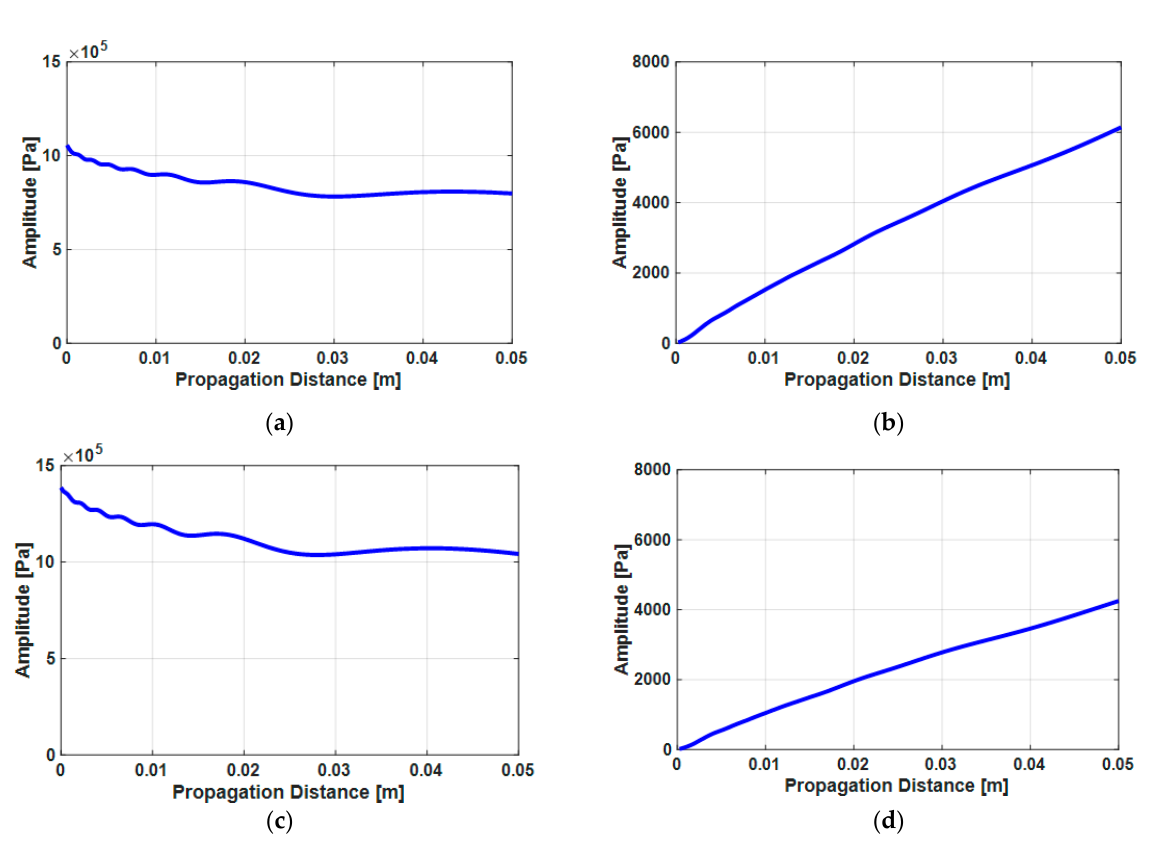
Figure 4. The received pressure amplitude on the receiver as a function of the distance to the transmitter, obtained from the average of the sound pressure in Figure 3: ( a ) the received fundamental amplitude and ( b ) the received second harmonic amplitude in the fused silica; ( c ) the received fundamental amplitude and ( d ) the received second harmonic amplitude in the Al6061-T6.